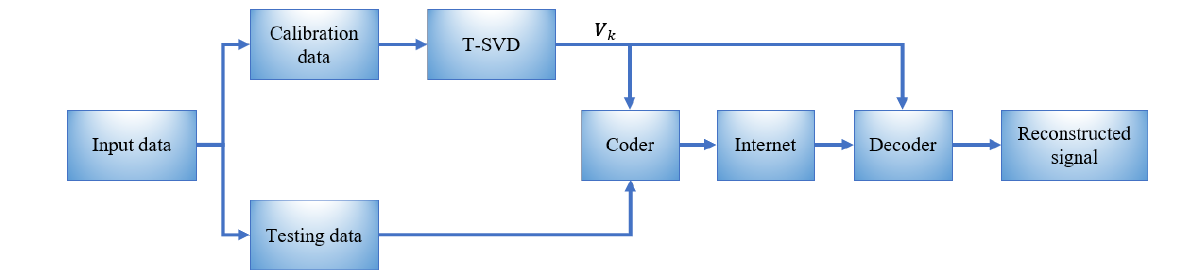
Figure 2. Conceptual diagram for the proposed